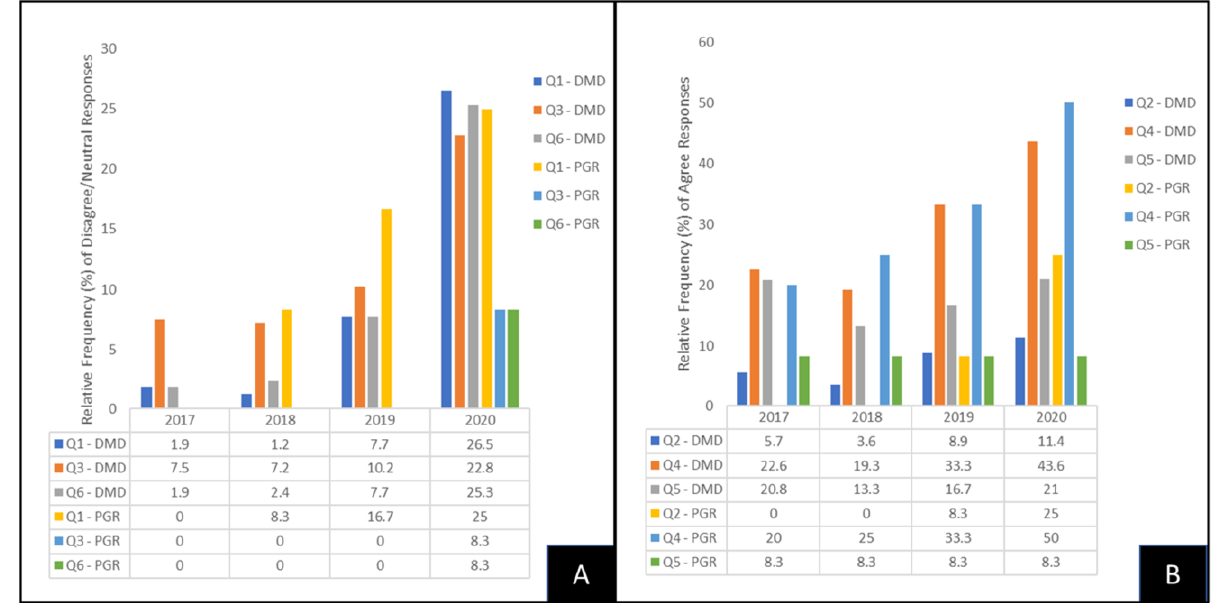
Figure 1. Graphic analysis of pro- and anti-vaccine response among DMD students and PG residents. ( A ) Relative frequency of disagree/neutral responses to pro-vaccines questions (Q1 Vaccines necessary; Q3 Vaccines safe; Q6 Vaccines effective) increased over time in both DMD and PGR cohorts. ( B ) Relative frequency of agree responses to anti-vaccine questions (Q2: Too many vaccines; Q4: Vaccines make you sick; also increased over time in both DMD and PGR cohorts, with increases observed among DMD but not PGR cohorts to Q5 (Vaccines dangerous).